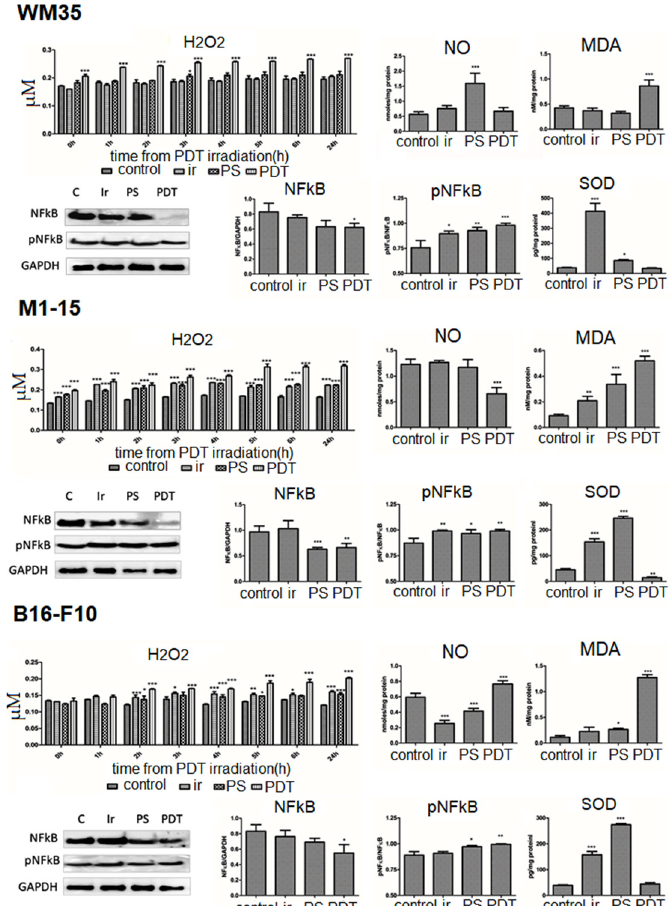
Figure 4. Oxidative stress. H 2 O 2 following PDT at different irradiation intervals (0 h–24 h). Nitric oxide (nM/mg protein) and malondialdehyde (nM/mg protein). Expression of NFkB and pNFkB. WB images, 1 = control, 2 = irradiated (100 mJ/cm 2 ), 3 = THPP (15 µg/mL), 4 = PDT (THPP 15 µg/mL and irradiation 100 mJ/cm 2 ) (left). Graphical representation of quantitative WB results (right): SOD1 (pg/mg protein) for WM35 (upper panel), M1-15 (middle panel), and B16-F10 (lower panel). Each bar represents mean ± SD, ( n = 3). * = p < 5.0 × 10 − 2 , ** = p < 1.0 × 10 − 2 , *** = p < 1.0 × 10 − 3 , compared to control.